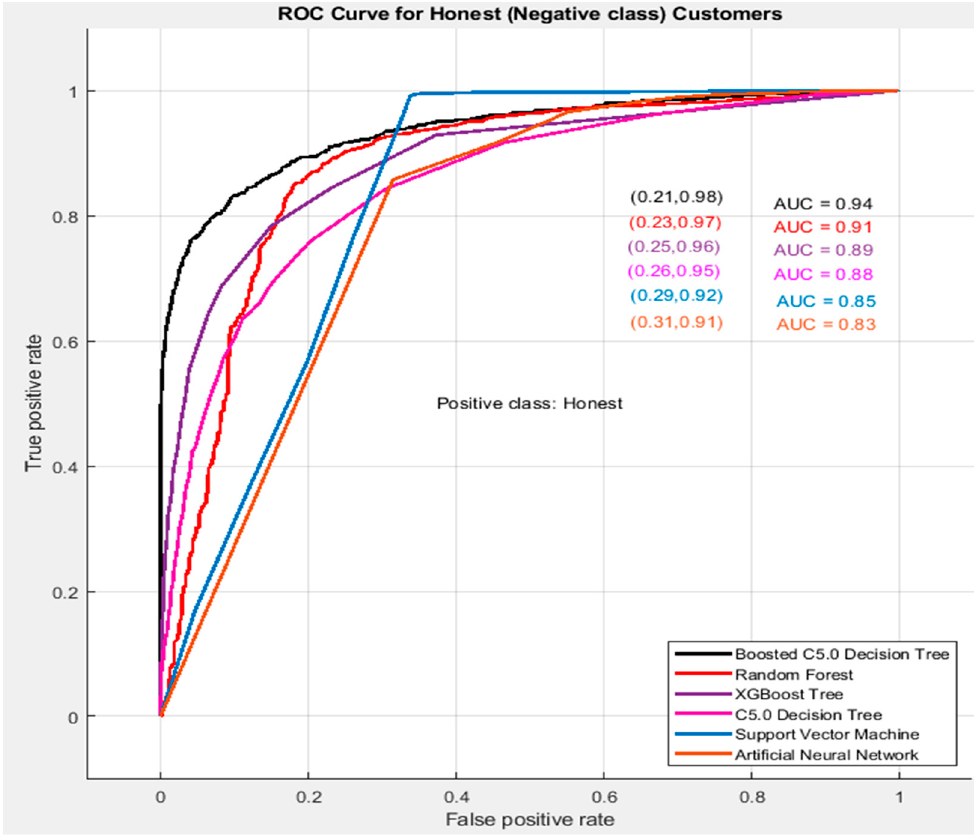
Figure 4. ROC Curve for Honest (negative class) Customers.